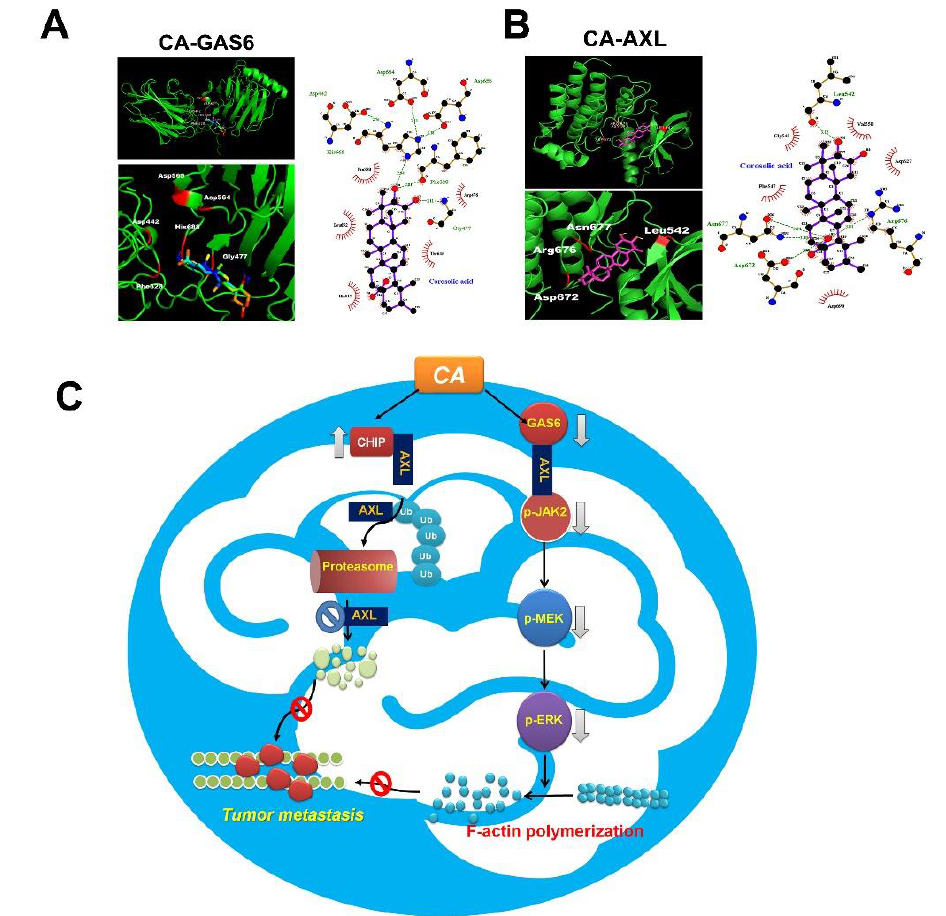
Figure 7. Molecular docking analysis and proposed mechanism for CA-inhibited invasiveness of GBM cells. ( A ) Superposition of GAS6 (green) and template CA (cyan), hydro-gen bonding interac- tions with GAS6 and CA. Binding affinity: − 7.6 kcal/mol. ( B ) Superposition of AXL (green) and tem- plate CA (cyan), hydrogen bonding interactions with AXL and CA. Binding affinity: − 5.6 kcal/mol. Interacting amino acid residues: Asn677, Arg676, Leu542 and Asp672. ( C ) Proposed mechanism for CA-inhibited invasiveness of GBM cells.